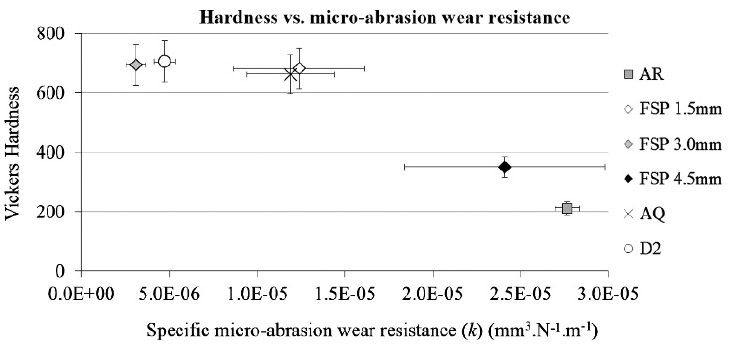
Figure 10. The relationship between wear and hardness for FSP AISI 420 martensitic stainless steel, reprinted with permission of Dodds et al., 2013 [70].